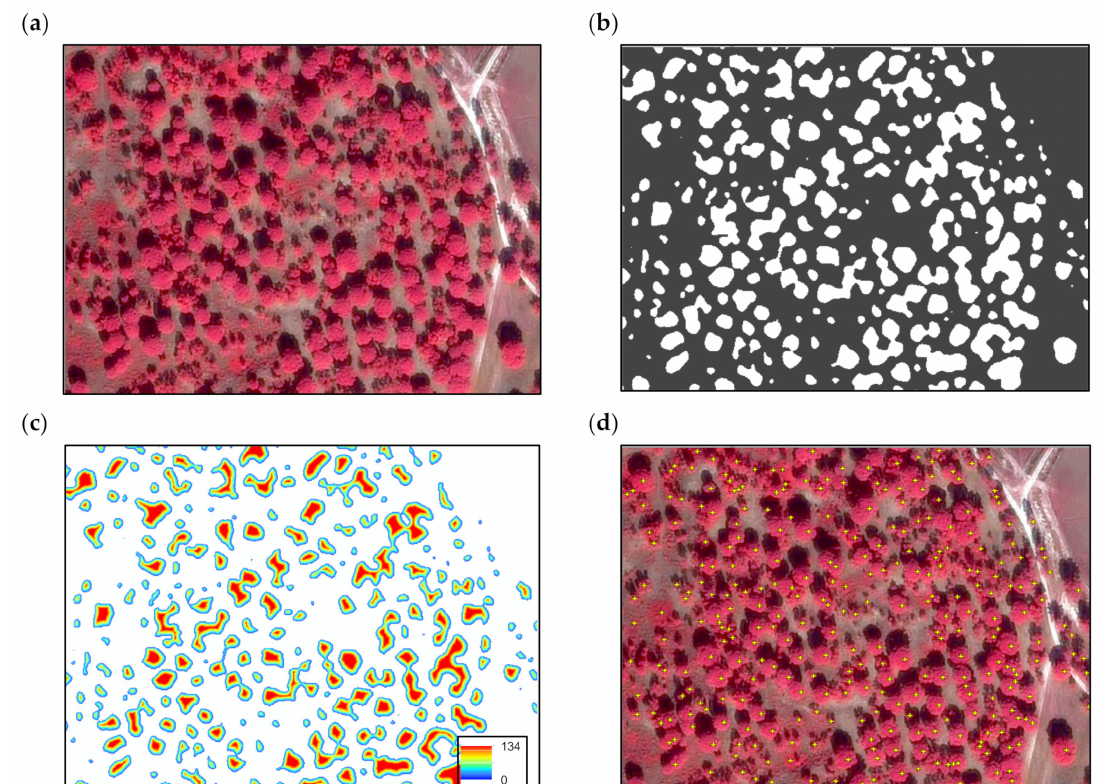
Figure 3. ( a ) False-color image (NIR, R, G); ( b ) Adaptative binarization; ( c ) Euclidean distance map; ( d ) Individual tree location obtained using the developed algorithm (yellow